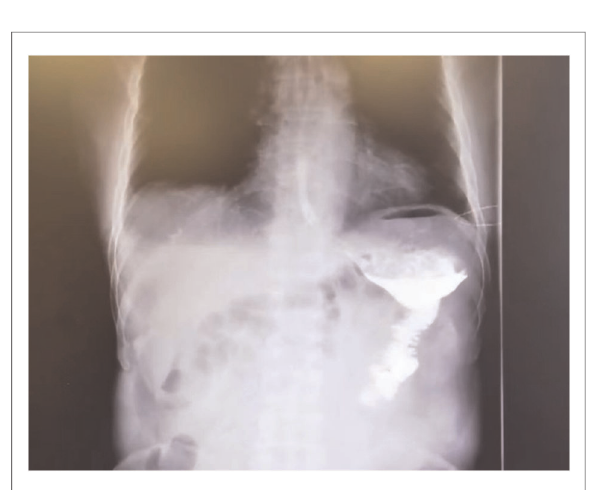
FIGURE 3 Six-month postoperative fl uorography showing smooth passage of oral water-soluble contrast medium without anastomosis stenosis.